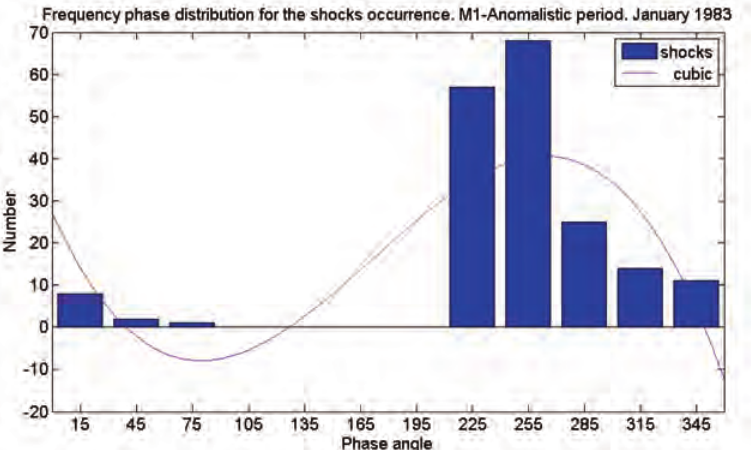
Figure 13. Cumulative histogram corresponding to the tidal period M1 anomalistic of the 186 events that occurred during January 1983 in the area of Zakynthos.